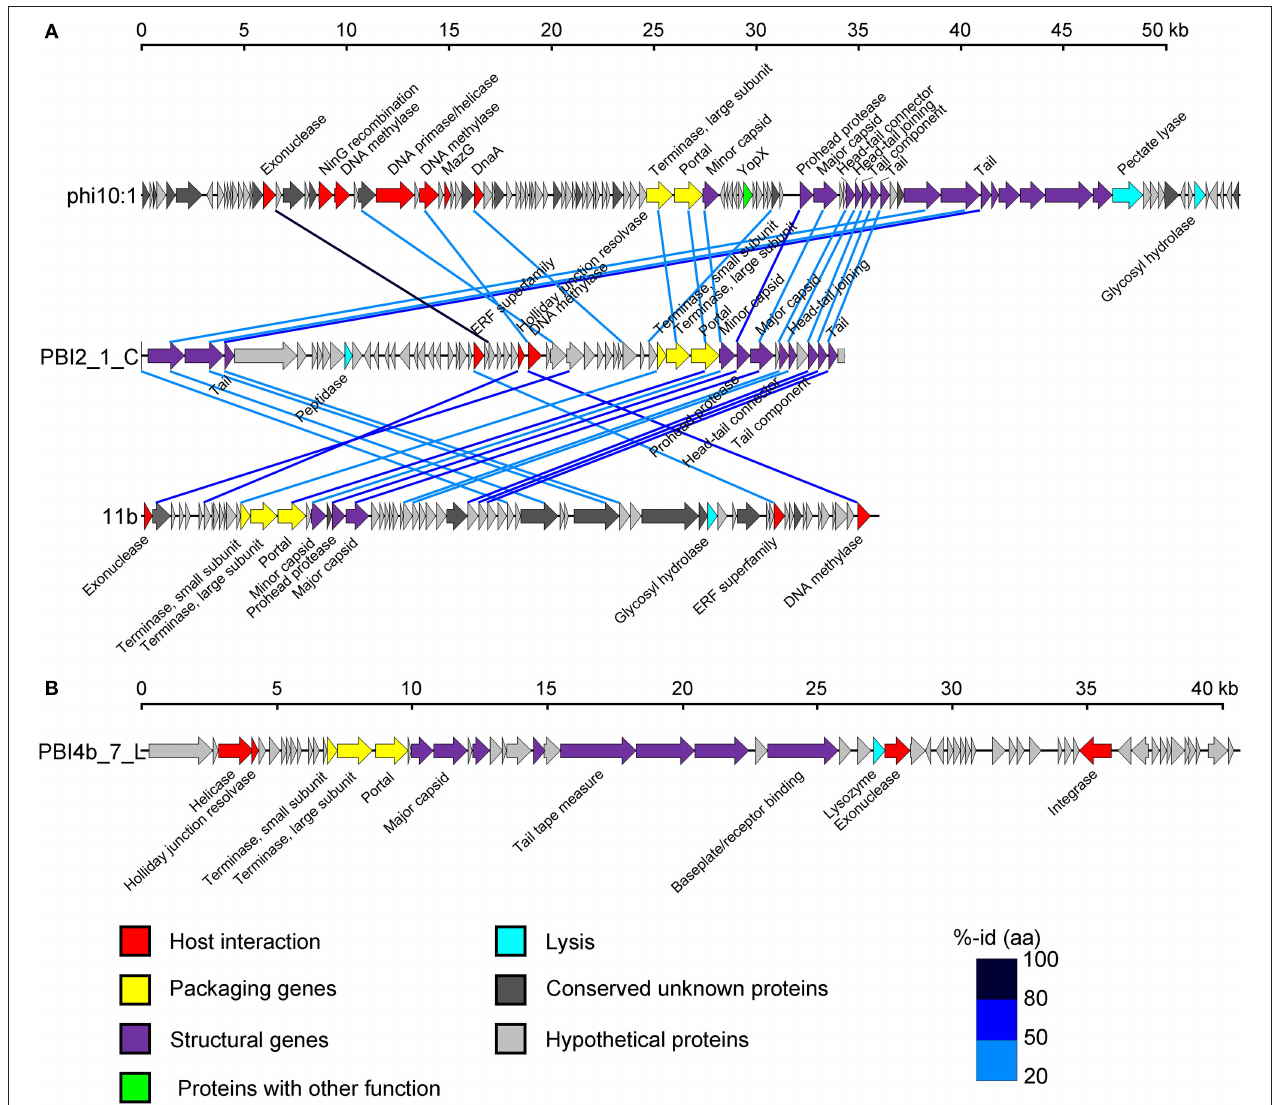
FIGURE 5 | Genome analysis of putative complete viral genomes identified from the viral metagenomes in the Prydz Bay, Antarctic. (A) Comparisons of putative phage PBI2_1_C with Cellulophaga phage phi10:1 (NC_021802.1) and Flavobacterium phage 11b (NC_006356.2). (B) Genome map of putative phage PBI4b_7_L. Arrows represent predicted ORFs. The color code for predicted gene function is provided at the bottom of the figure. Homologous ORFs are connected by blue lines. %-id (aa) = amino acid